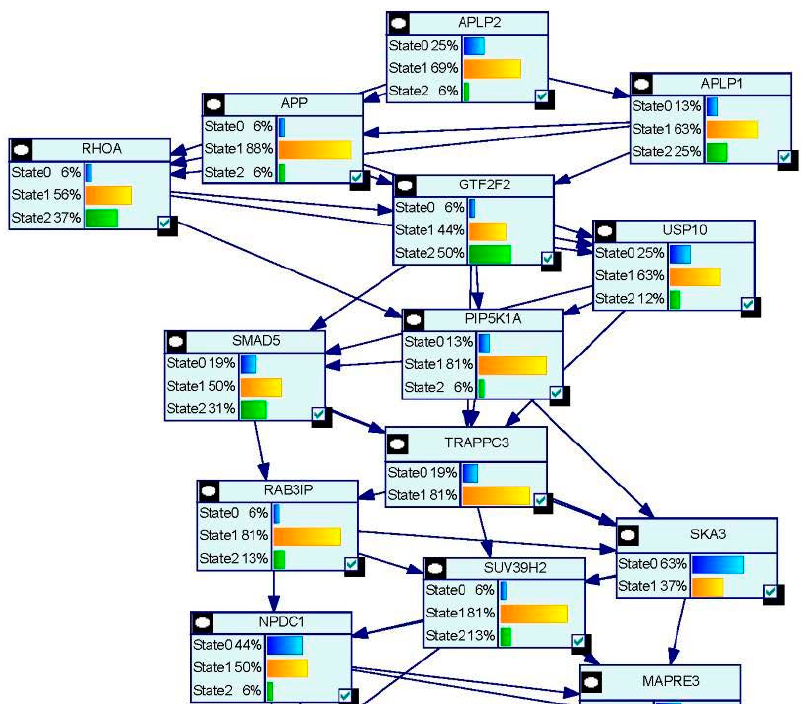
Figure 13. Causal network analysis of gender and NRF1 association with AD in hippocampal microarray [272].